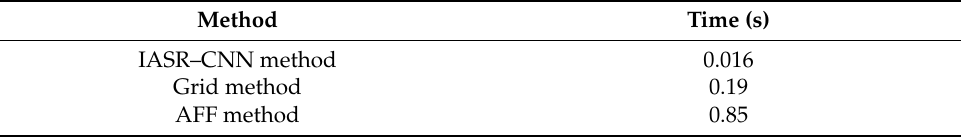
Table 3. Time required for image reconstruction by the different